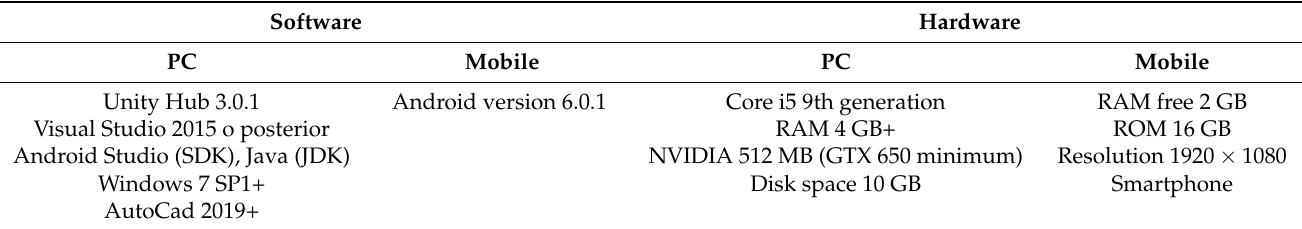
Table 1. Software and hardware